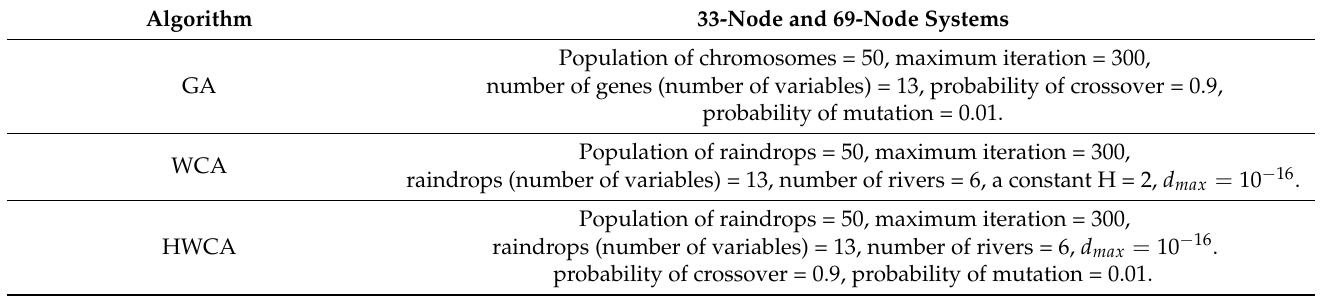
Figure 11. Convergence curve of the IEEE 33-node system using compared algorithms for case 6. Table 4. Compared numerical results of HWCA for case 6 with WCA and GA for the 69-node sys- tem.